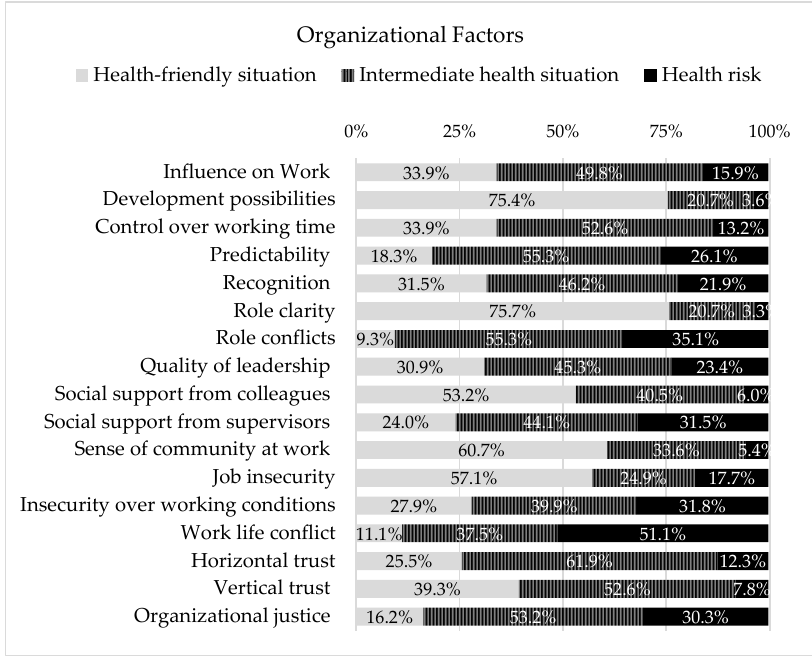
Figure 2. PRFs framed in the element of Organizational factors, of work system (of SEIPS 3.0 model), and the respective health risk that the exposure represents.